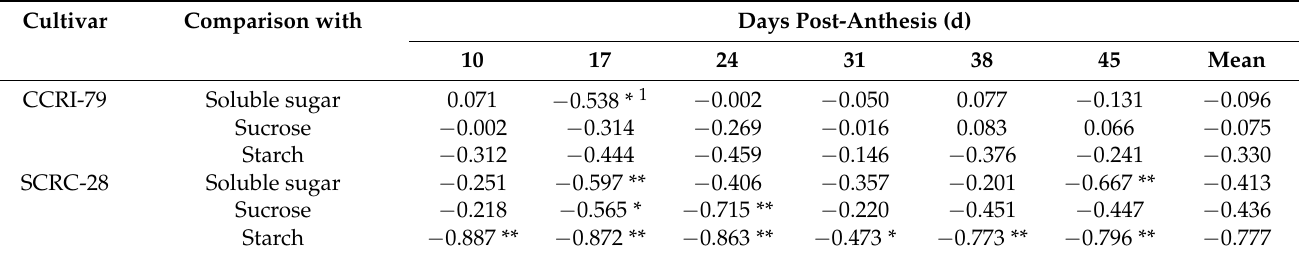
Table 3. Correlation between carbohydrate content and P concentration of the subtending leaves in 2019 and 2020 cotton-growing periods. (n = 18, R 0.05 = 0.468, R 0.01 = 0.590).